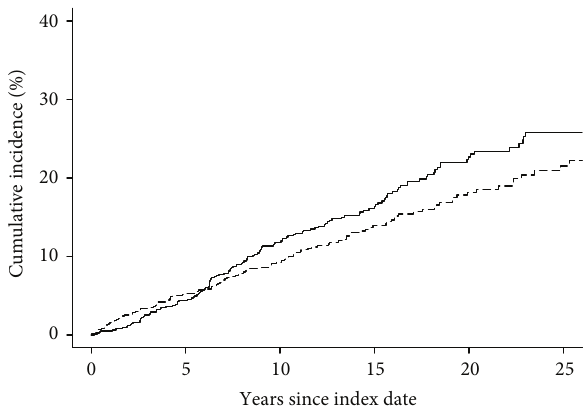
Figure 1: Cumulative incidence of any malignancy excluding nonmelanotic skin cancers among Olmsted County, Minnesota, residents with rheumatoid arthritis (solid line) compared to those without rheumatoid arthritis (dashed